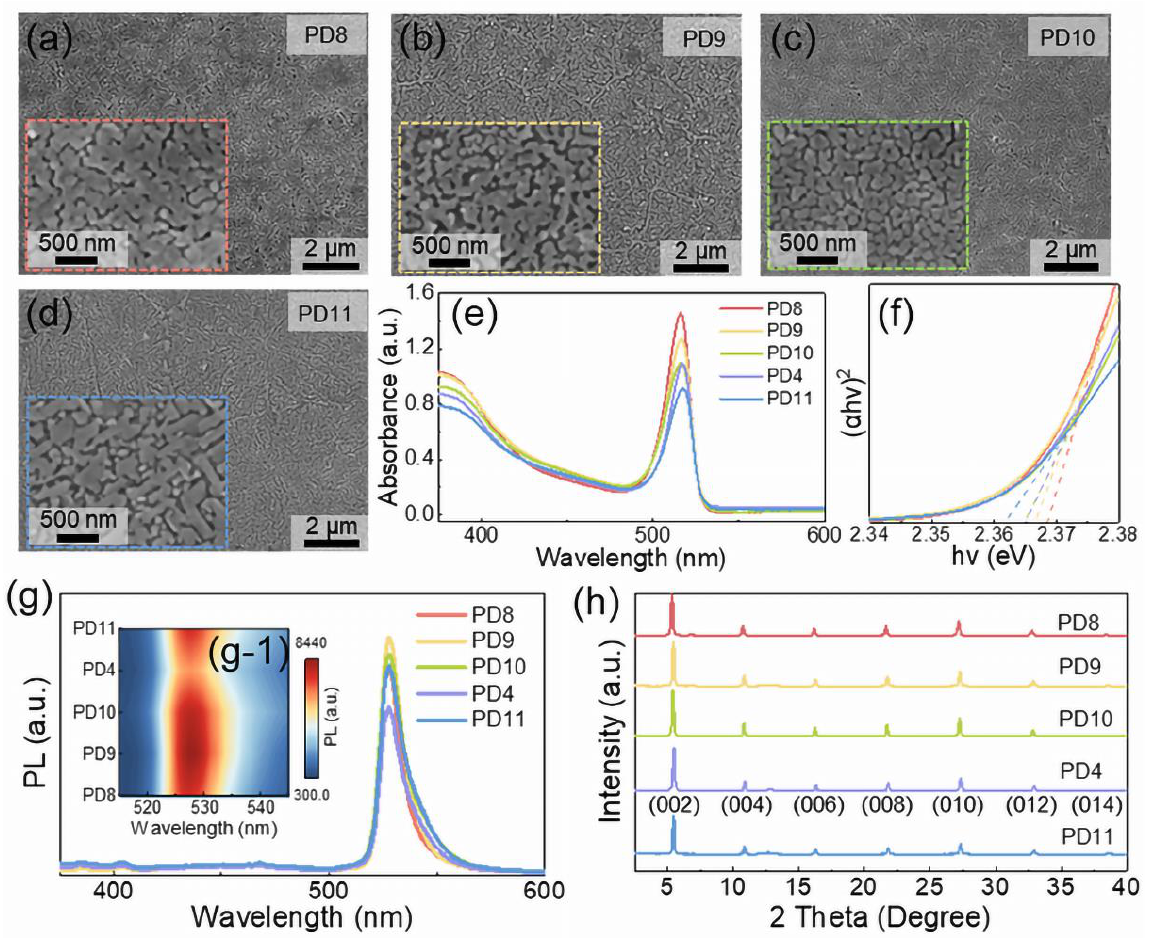
Figure 5. SEM images of the ZnO QD/(PEA) 2 PBI 4 nanosheet devices fabricated with a 0.097 mg/mL ZnO QD chloroform antisolvent at different annealing temperatures: ( a ) room temperature (PD8), ( b ) 80 °C (PD9), ( c ) 100 °C (PD10), and ( d ) 140 °C (PD11). ( e ) Absorbance spectra and ( f ) Tauc plots of the samples. ( g ) The PL spectra and ( g-1 ) the contour maps of wavelength-dependent PL for the devices. ( h ) XRD spectra of each sample. Table 3. Comparison of the photodetector performance created from different perovskite materials.